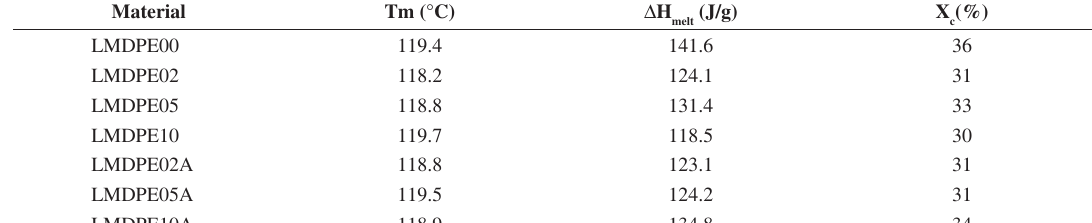
Table 5. DSC results of rotational molded samples.